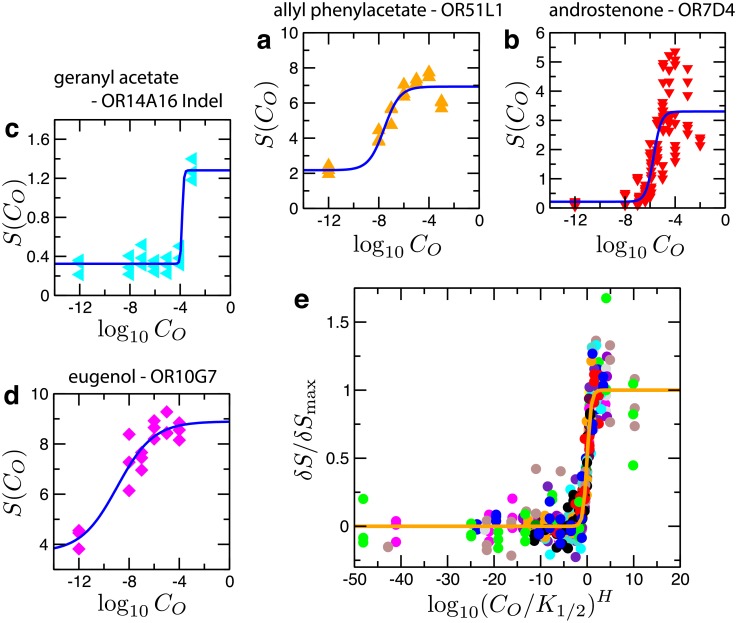
Analysis of dose-response data for odorant-OR pairs.Examples of fit using Eq 3 are shown for some odorant-receptor pairs: a. allyl phenylacetate−OR51L1 (B = 2.18, δSmax = 4.76, log10
K1/2 = −7.56, H = 0.7); b. androstenone−OR7D4 (B = 0.21, δSmax = 3.09, log10
K1/2 = −5.72, H = 1.4); c. geranyl acetate−OR14A16 Indel (B = 0.32, δSmax = 0.96, log10
K1/2 = −3.84, H = 6.6); d. eugenol−OR10G7 (B = 3.69, δSmax = 5.21, log10
K1/2 = −8.95, H = 0.3). e. Dose-response data for 22 odorant-OR pairs collapsed onto a universal curve, f = 10ξ/(1 + 10ξ), where f = δS/δSmax and ξ = Hlog10(CO/K1/2) (orange line). For clarity, only the data from 22 activating pairs are presented.